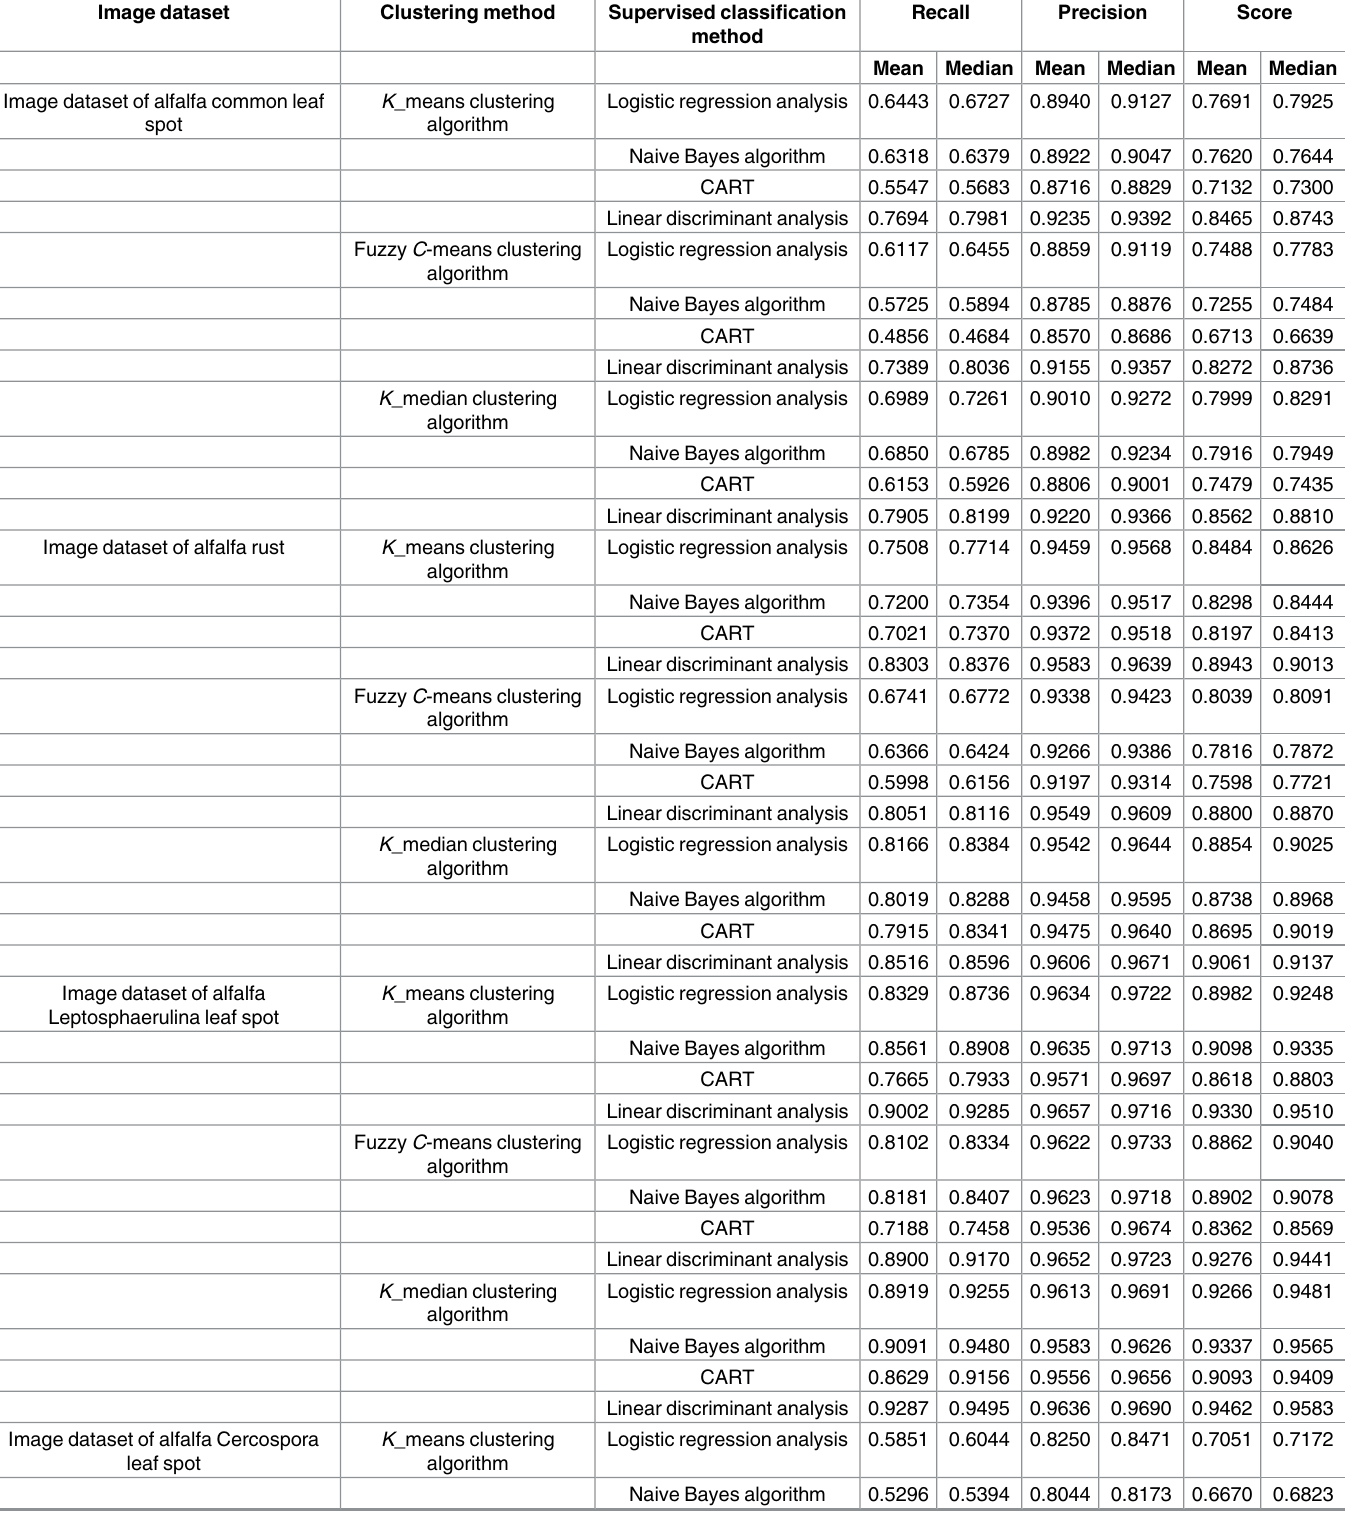
Table 2. Performanceevaluations of the twelve segmentation methods based on the sub-images of four alfalfa leaf